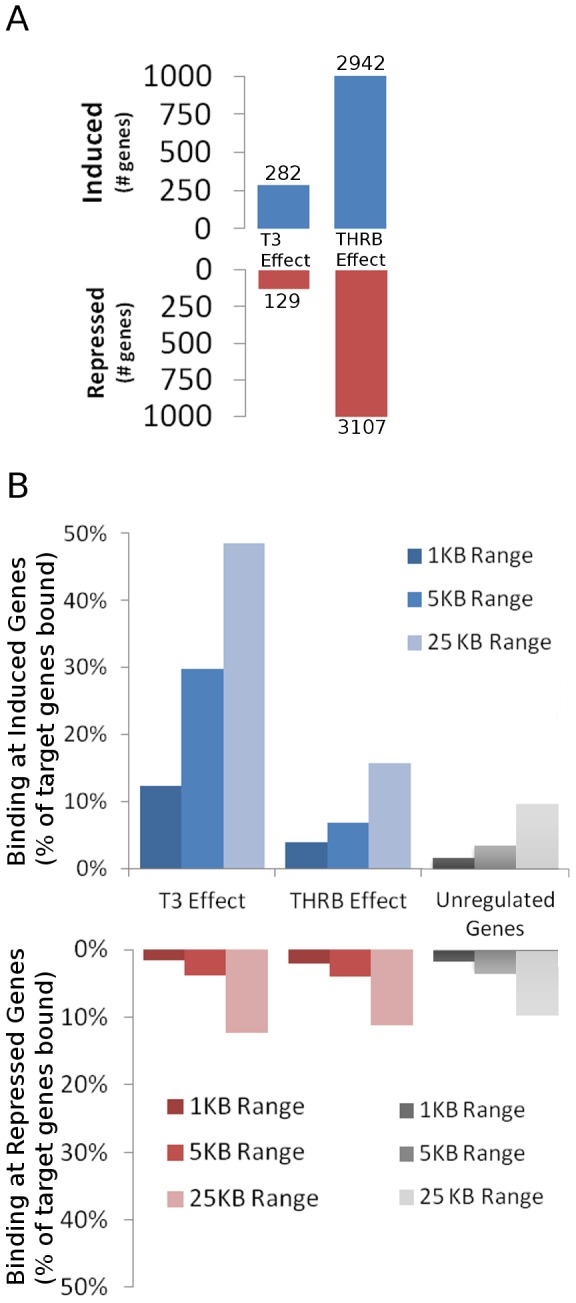
Links between TRβ Binding and regulatory events.A. Bar graph representing numbers of genes that display positive regulation (upper panel) or negative regulation (lower panel) that met statistical significance and an arbitrary +/−1.7-fold cut-off in an array-based analysis of TRβ-BioChIP cells +/−T3 or in TRβ-BioChIP cells versus parental cells that lack TRβ (THRB effect). B. Bar graph representing percentages of TRβ binding events within 1 KB, 5 KB or 25 KB of the TSS of T3 induced, TRβ induced or unaffected genes (upper panel) or T3 or TRβ repressed genes (lower panel). Progressively lighter shading in the bar graph columns represents increasing distance from the TSS.